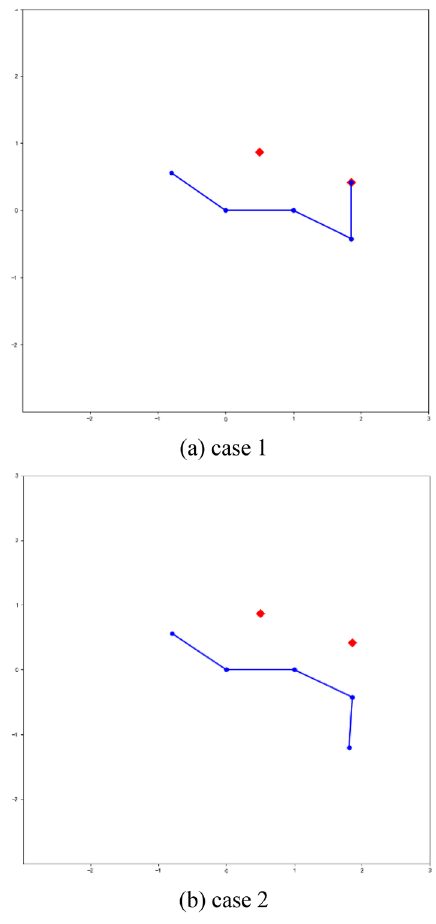
Figure 9. Normalized data of the two extracted training